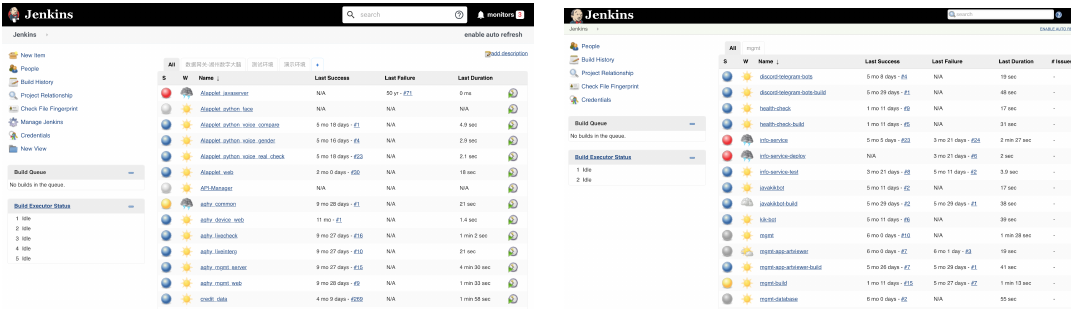
Figure A11. Examples of Jenkins dashboards found with